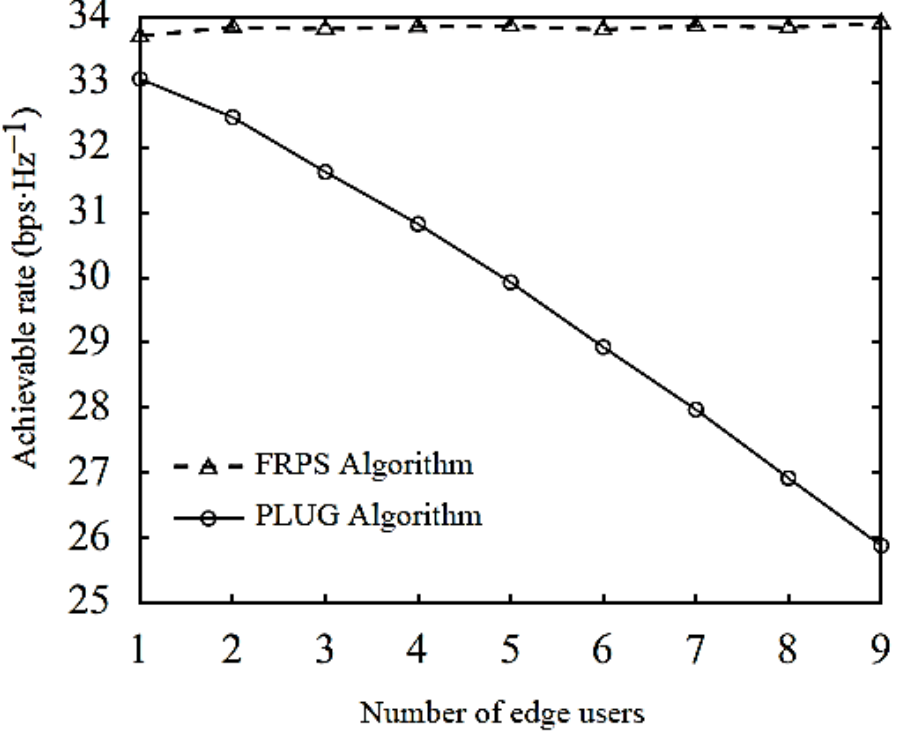
Figure 12. Comparison of achievable sum rate against a different number of edge users for FRPS and PLUG algorithms.